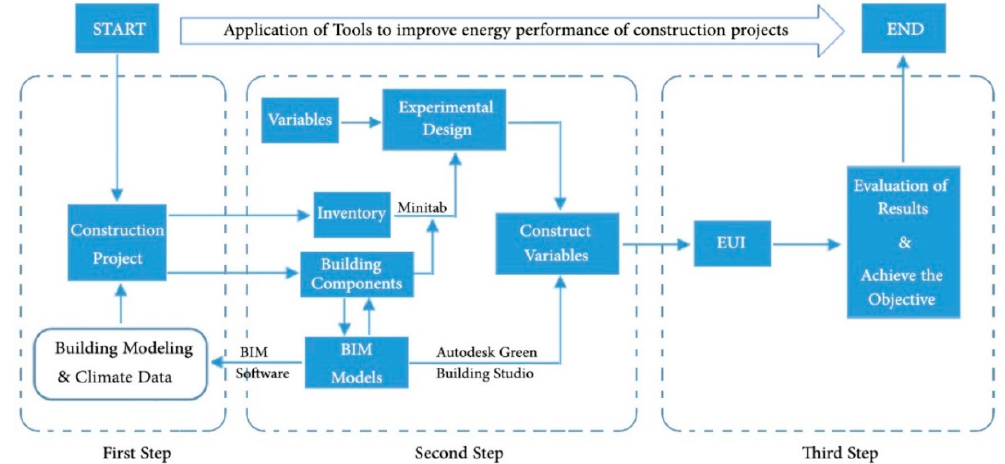
Figure 6. Linking framework components.